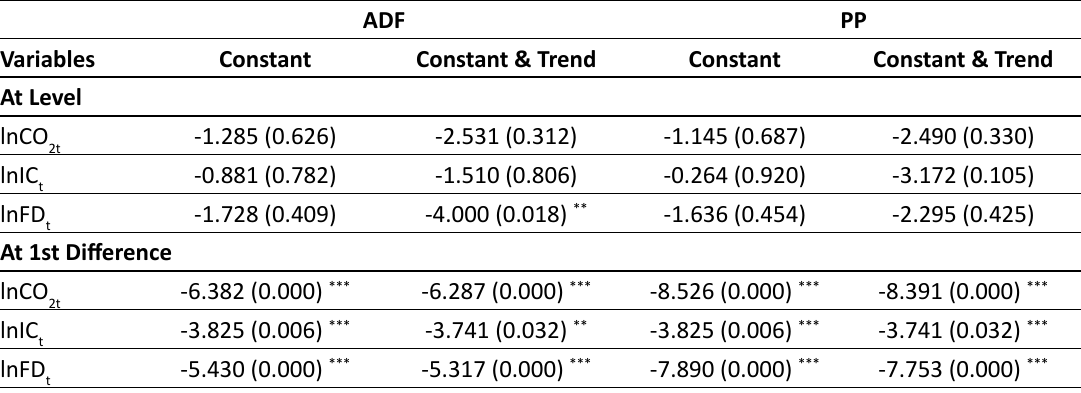
Table 3: Unit Root Tests